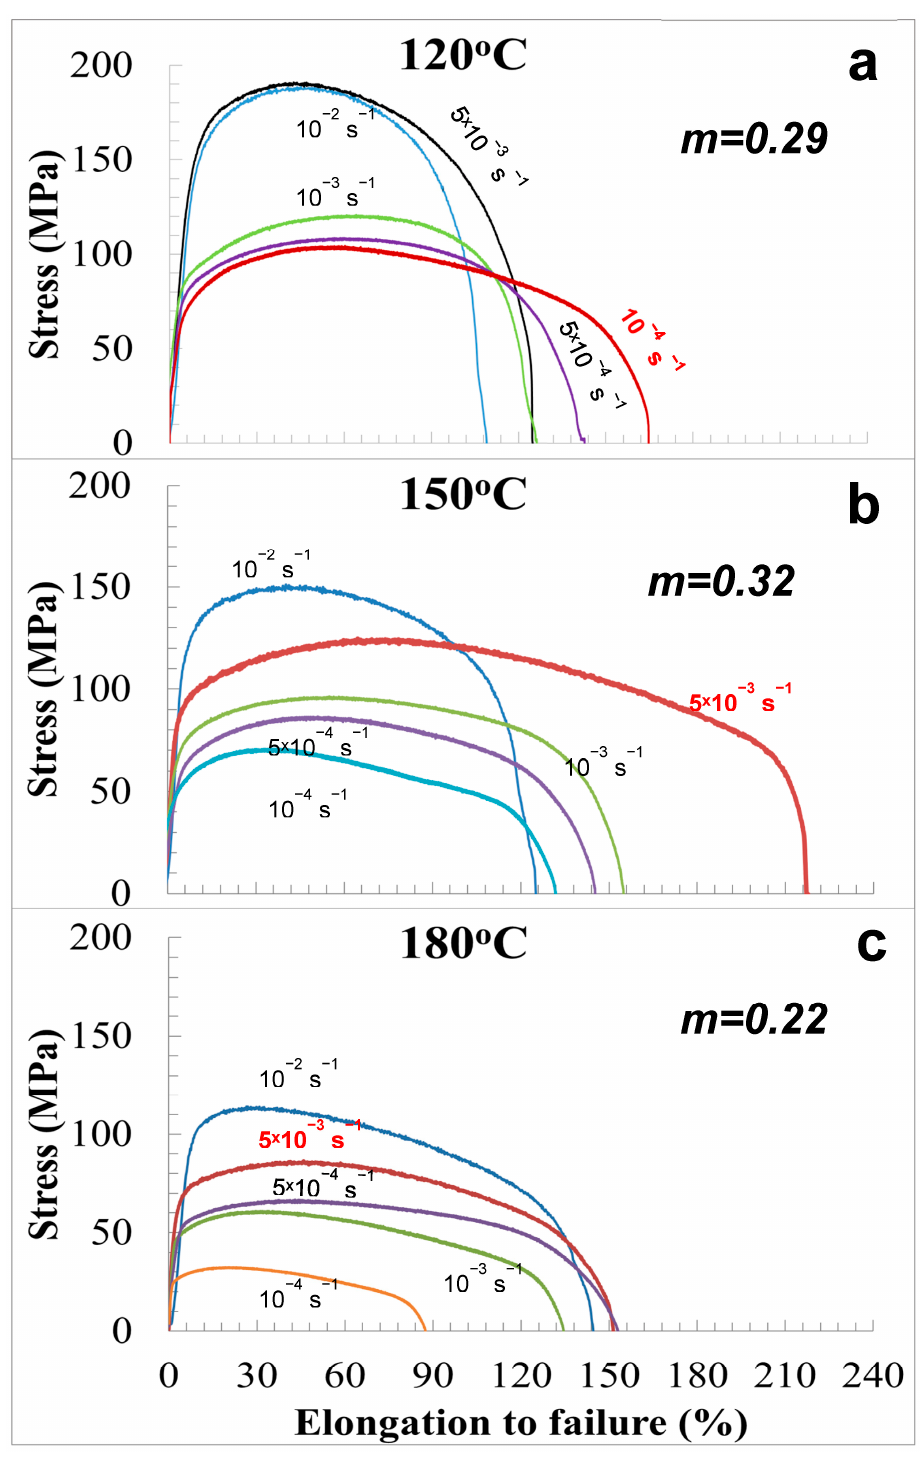
Figure 3. The stress − strain curves for the UFG 6060 alloy for different strain rates and deformation temperatures of: ( a ) 120 ◦ C (0.42 T m ); ( b ) 150 ◦ C (0.46 T m ); and ( c ) 180 ◦ C (0.48 T m ). For all cases, the curves are characterized by pronounced strain hardening and a smooth decrease in the flow stress after achieving peak values. As it is assumed, the observed strain hardening is related to multiple intragranular slip, with no steady-state